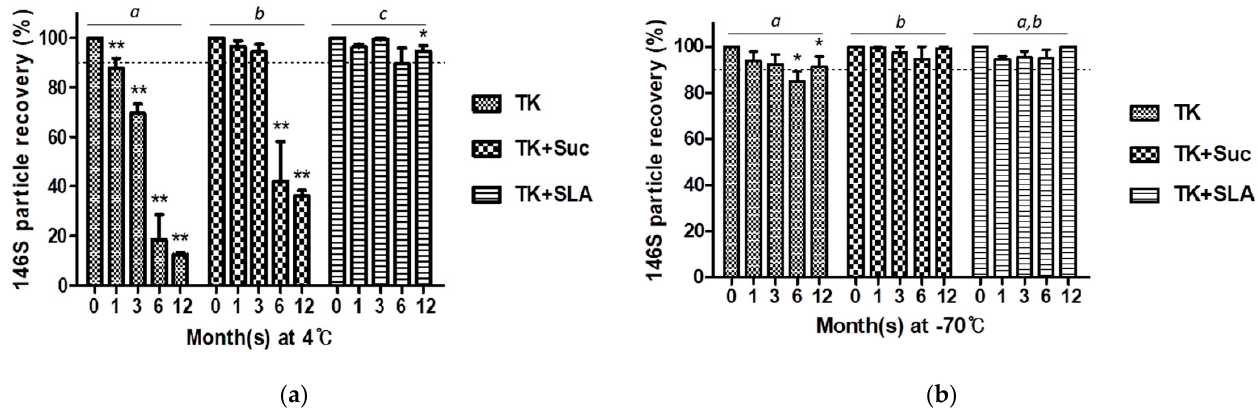
Figure 4. Effectivity of excipients for long-term storage of FMDV O JC vaccine antigen. ( a ) The 146S particle recovery (%) in each buffer during 1-year storage at 4 °C; ( b ) The 146S particle recovery (%) in each buffer during 1-year storage at − 70 °C. The dotted line is set at 90% recovery. *, p < 0.05, **, p < 0.01. Different lowercase letters indicate significant differences at p < 0.05. Abbreviations: TK, Tris-KCl buffer (pH 7.6); Suc, 20% sucrose; SLA, 10% sucrose with 5% lactalbumin hydrolysate.